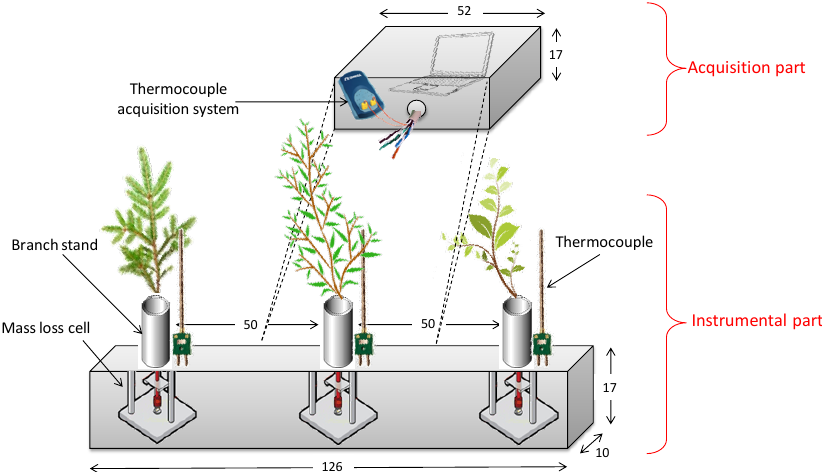
Figure 2. The differential mass-loss prototype (measurements are expressed in centimetres).